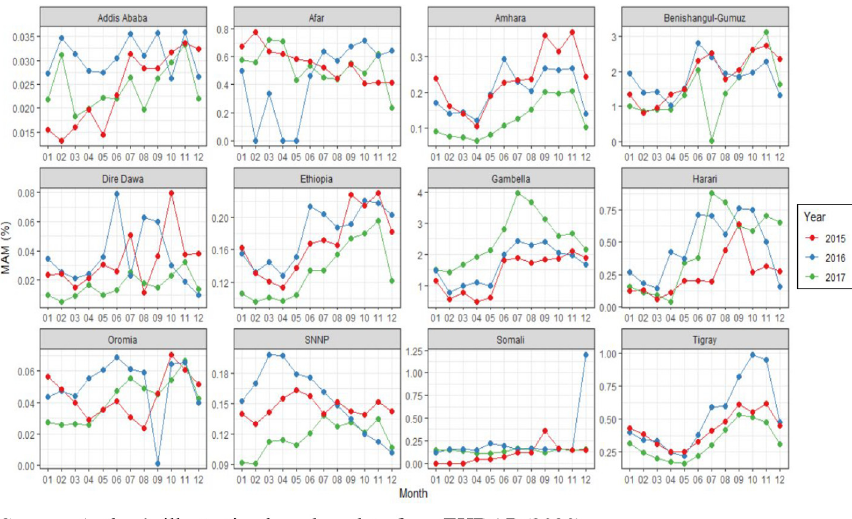
Figure 3. Monthly MAM in